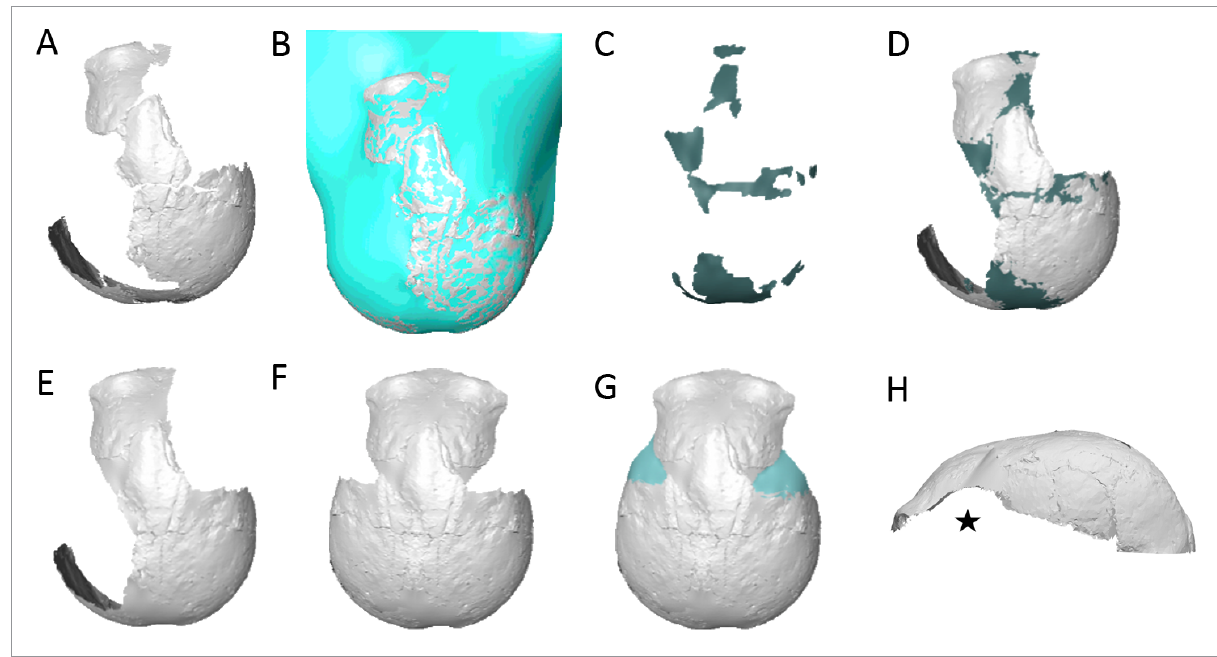
Figure 2: Successive steps for the virtual reconstruction of the StW 578 cranium. The initial surface (A) has been wrapped using a patch (B) and the gaps reconstructed (C) and merged with the initial surface (D). To the end result of the first iteration (E), a mirror was applied (F) and the overall process repeated (G). The resulting surface is lacking lateral portions of the frontal and parietal bones (H) indicated by a